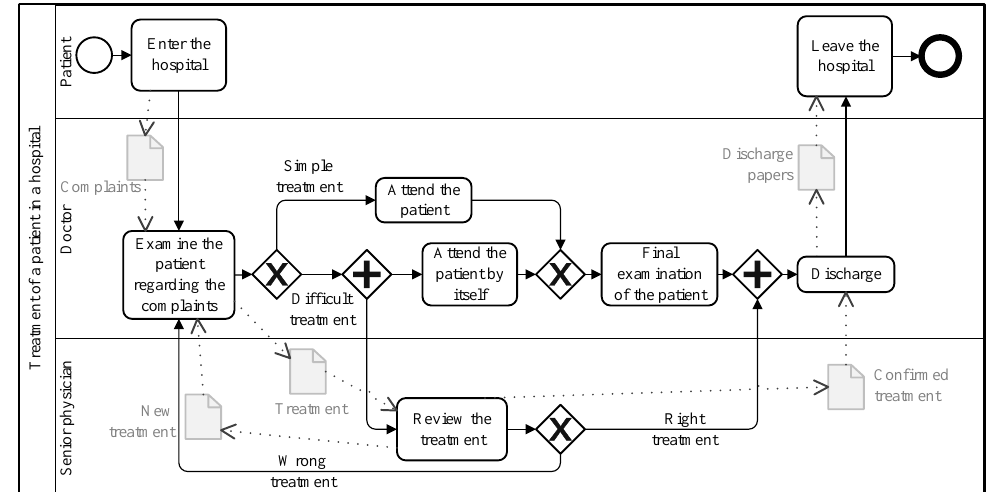
Figure 1. A workflow in